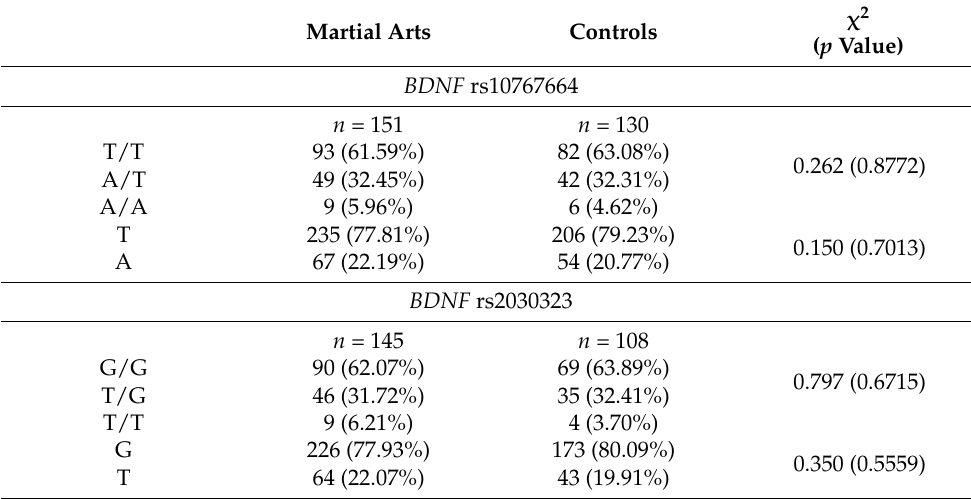
Table 2. Frequency of genotypes and alleles of BDNF rs10767664 and BDNF rs2030323 in the groups of martial arts subjects and controls.